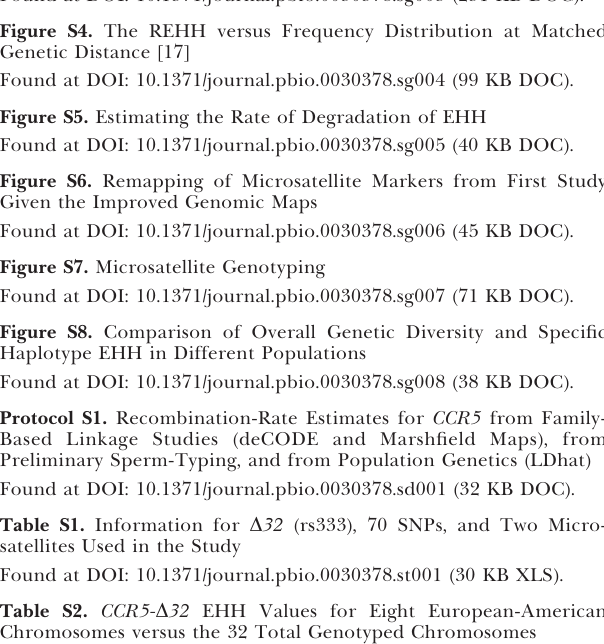
Table S3. Haplotype Frequencies for Six Variants in Strong LD at CCR5, Genotyped in the Three Population Samples Table S4. Extended Haplotype Length for Haplotypes of Different Frequency on HapMap Chromosome 3 in European-Americans Table S5. Details of CCR5- D 32 Date